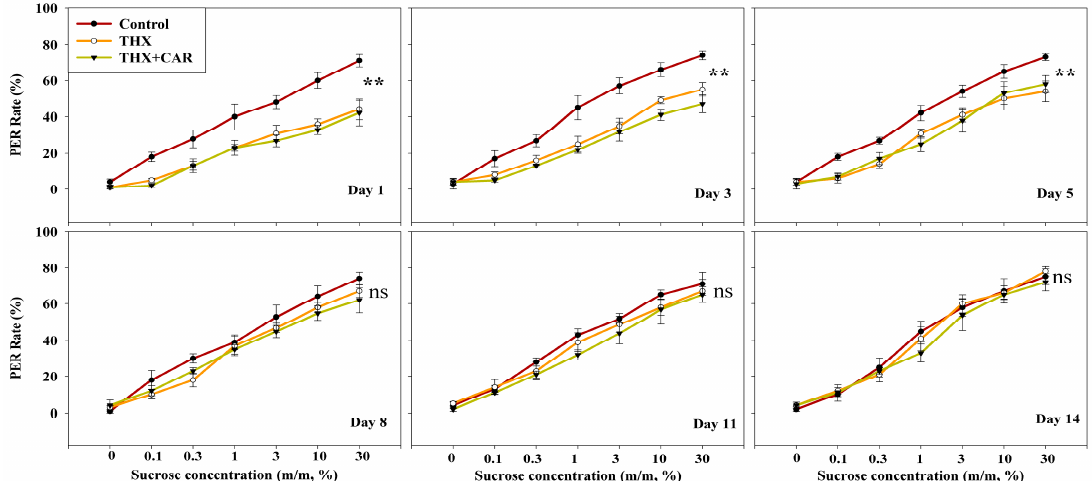
Figure 4. The thiamethoxam (THX) and thiamethoxam + carbendazol mixture (THX + CAR) reduced bee sugar responsiveness scores, after one week bees responded to sucrose the same as the controls. ** presents great significant difference ( p < 0.01), ns means no significant difference ( p > 0.05).